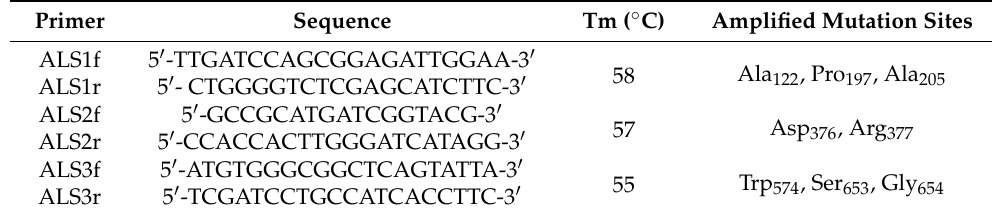
Table 4. Primers used in this